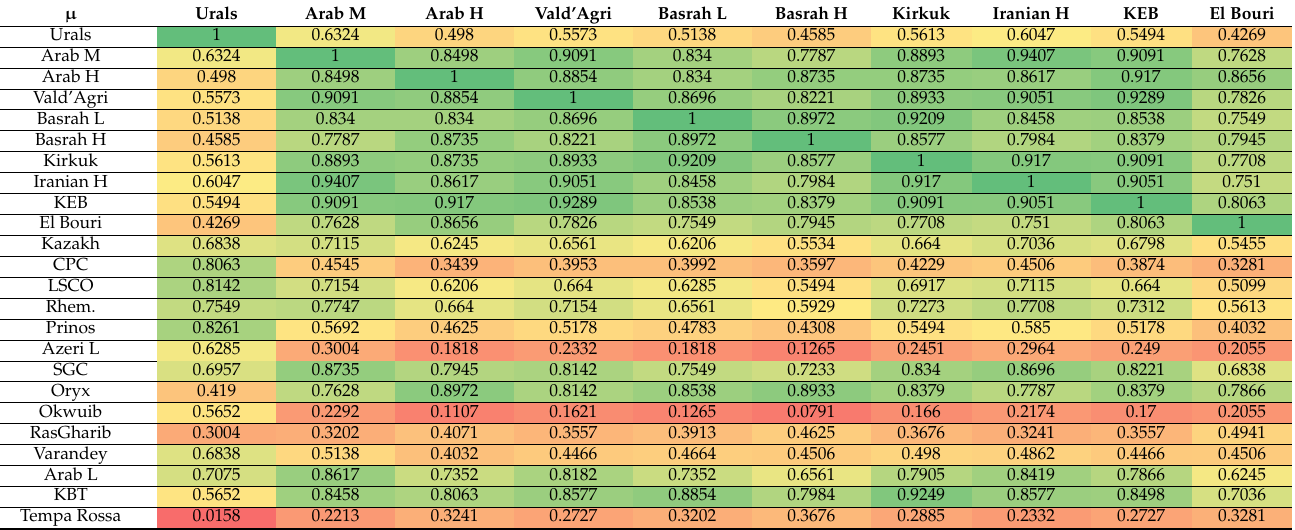
Note: Green color denotes statistically meaningful positive relation; red color denotes statistically meaningful negative relation. The intensity of the color designates the strength of the relation. The higher the color intensity, the higher the strength of the relation. Yellow color denotes